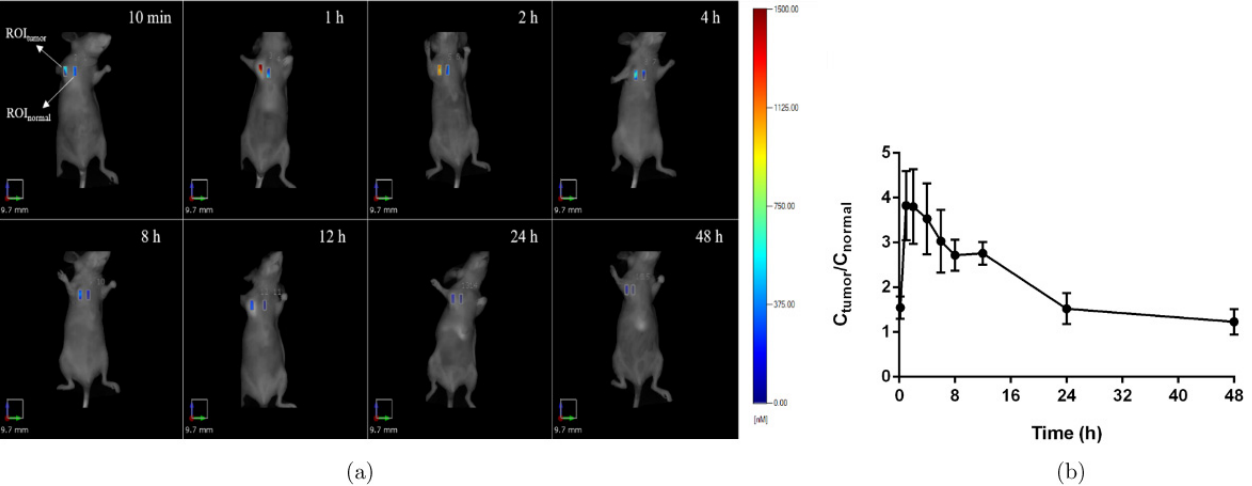
Fig. 10. Tumor speci¯city of Photocyanine in BALB/c nude mice bearing EC 109 tumors. (a) in vivo 3D optical imaging at predetermined time points; (b) Photocyanine concentration ratio (CR) in the corresponding ROIs ( n ¼